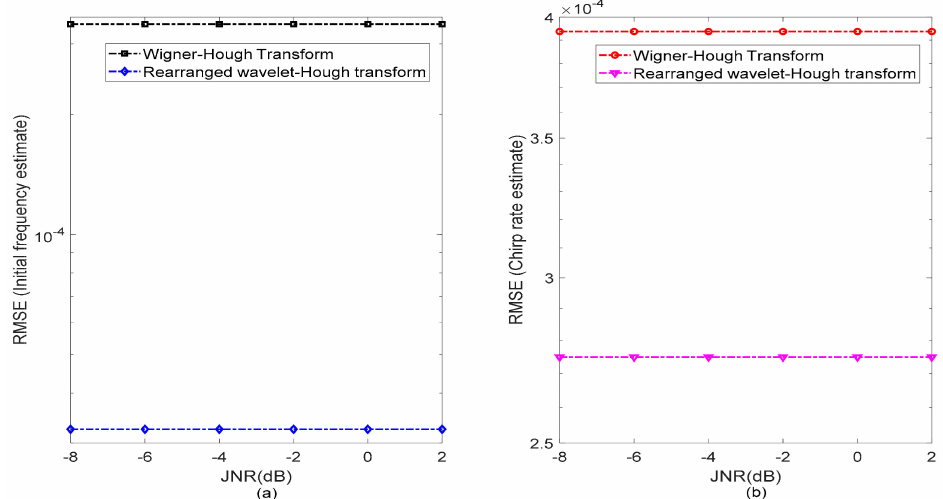
Figure 13. The RMSE of the estimated chirp rate and initial frequency of the sweep interference present in the received GPS L1-C/A signal by using Wigner–Hough transform and rearranged Wavelet–Hough transform, respectively. C / N 0 = 40 dB-Hz. ( a ) RMSE of the estimated initial frequency of the sweep interference; ( b ) RMSE of the estimated chirp rate of the sweep interference.